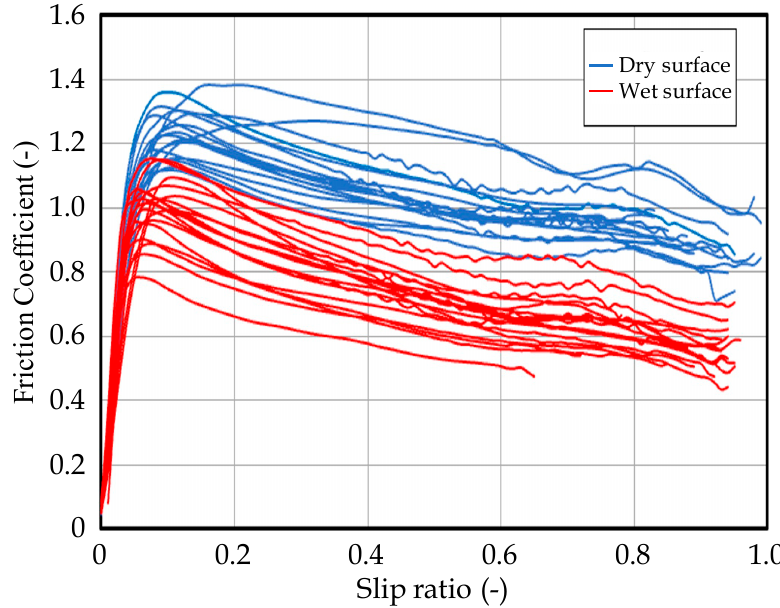
order to confirm the difference in these road surface conditions, the wet surface condition and the dry surface condition are classified, and the characteristic difference is shown in Figure 3. From Figure 3, it can be seen that the road friction characteristics on wet surfaces are significantly reduced compared to dry roads as a whole, and the characteristics shown in Figure 1.